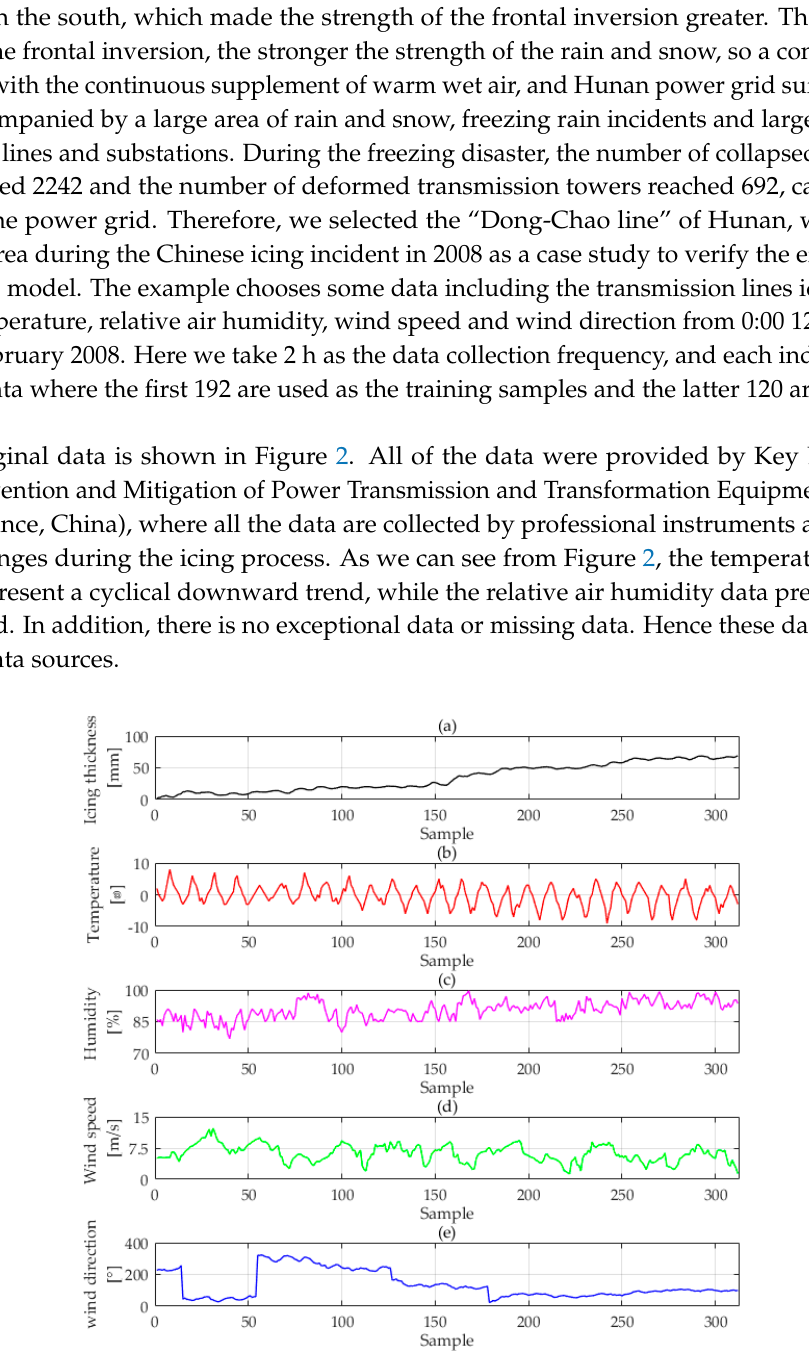
Figure 2. Original data chart of icing thickness, temperature, humidity, wind speed, and wind direction. Note: ( a ) represents the original data of icing thickness; ( b ) represents the original data of temperature; ( c ) represents the original data of humidity; ( d ) represents the original data of wind speed; ( e ) represents the original data of wind direction. Table 1. RMSE of proposed model when selecting the input icing thickness data at different time point. z 1 2 3